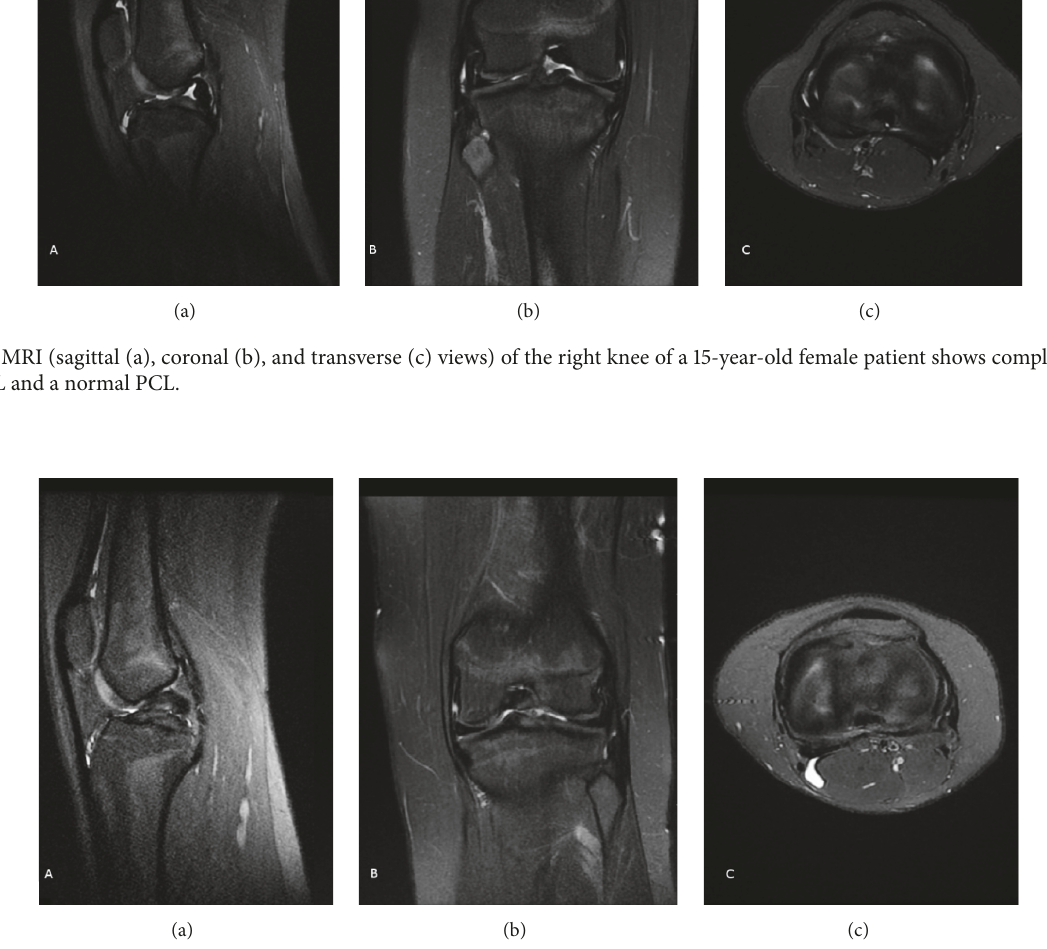
Figure 7: MRI (sagittal (a), coronal (b), and transverse (c) views) of the left knee of the patient from Figure 6 showing the same findings as her right